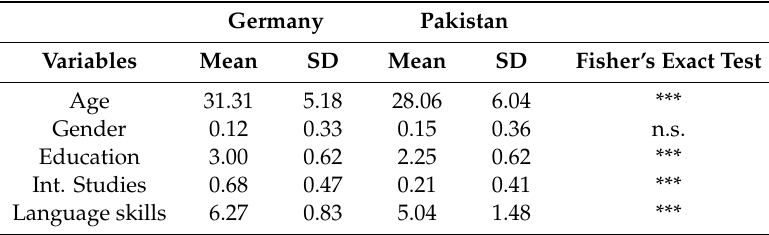
Table 2. Means, Standard Deviations, and Fisher’s exact test.